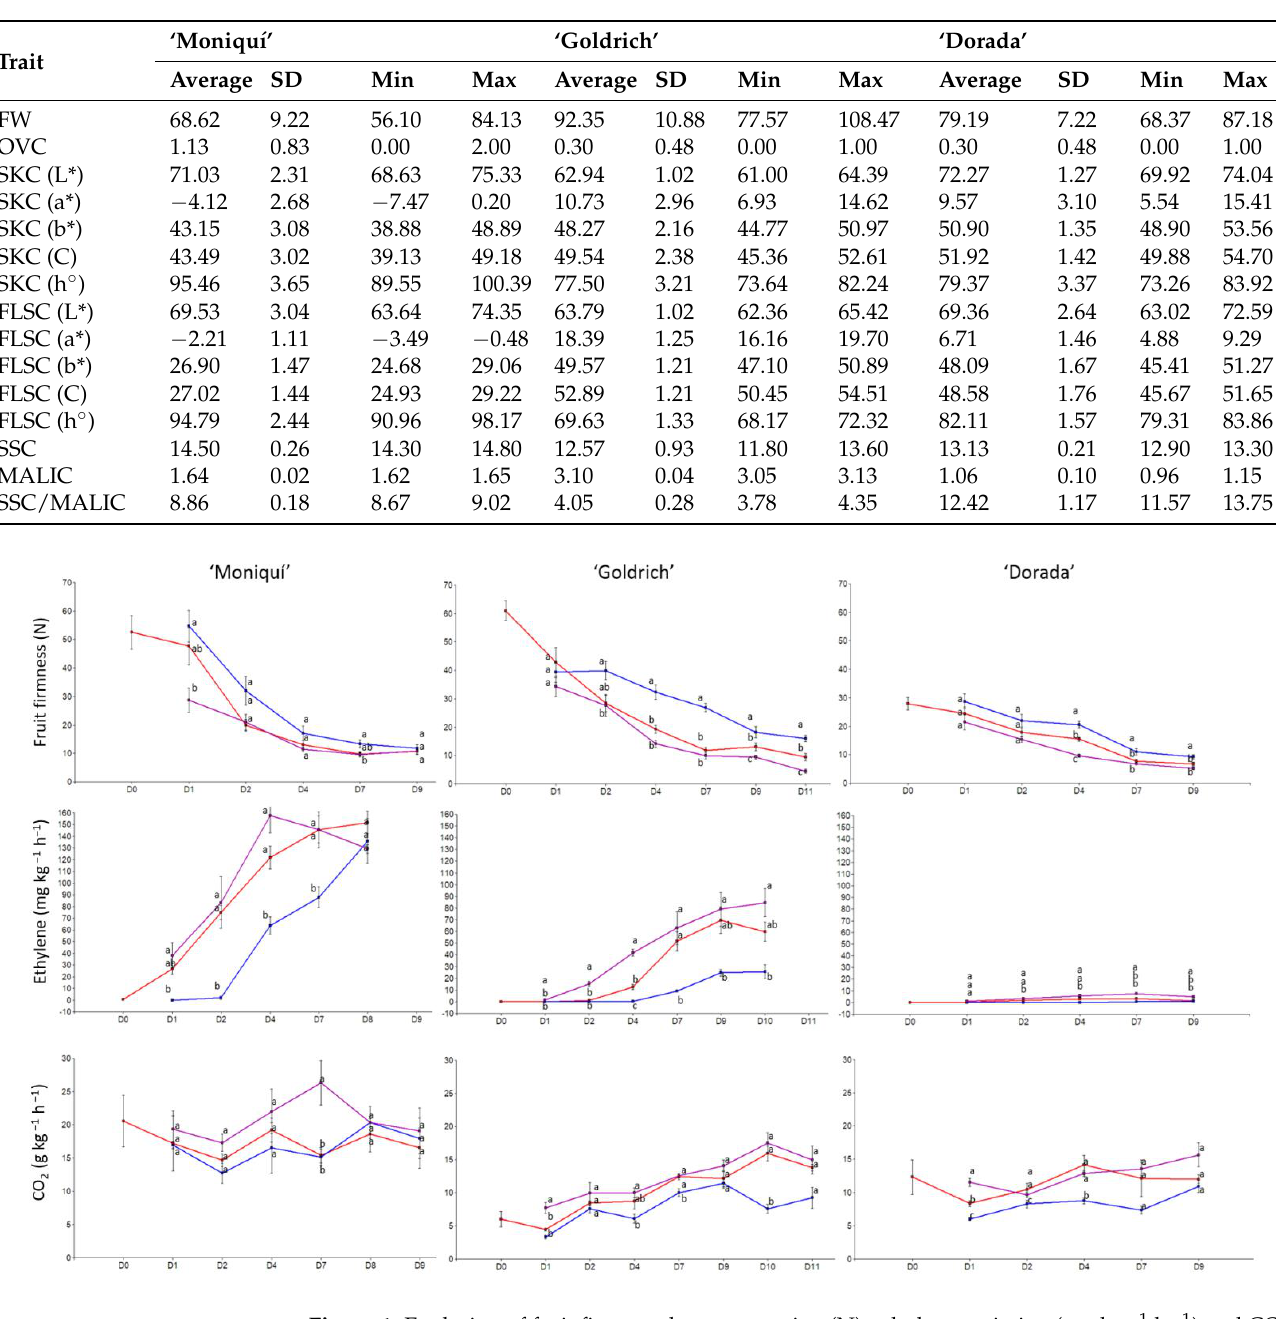
Figure 1. Evolution of fruit firmness by compression (N), ethylene emission (mg kg −1 h −1 ) and CO 2 emission (g kg −1 h −1 ) of apricot cultivars assayed during the shelf-life period at 20 °C for control (red color), 1-MCP (blue color), and Ethrel treatments (purple color). Letters show significant differences in the Tukey test ( p -value < 0.05).